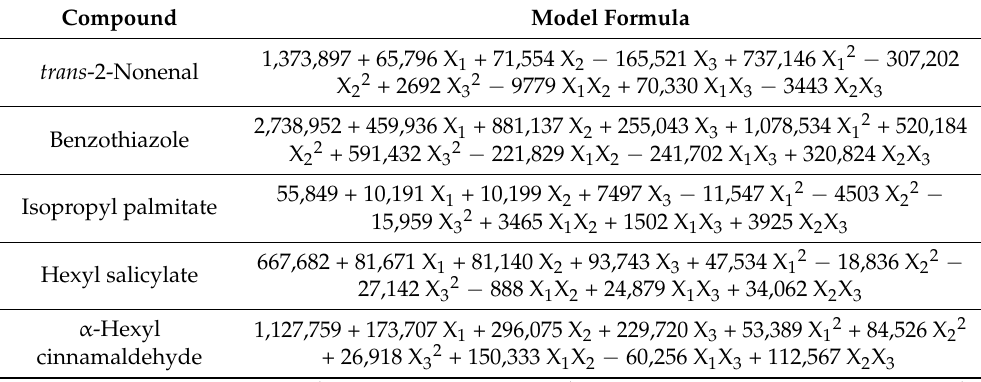
Table 1. Peak area prediction formula of each material obtained through BBD in optimization of the reactant